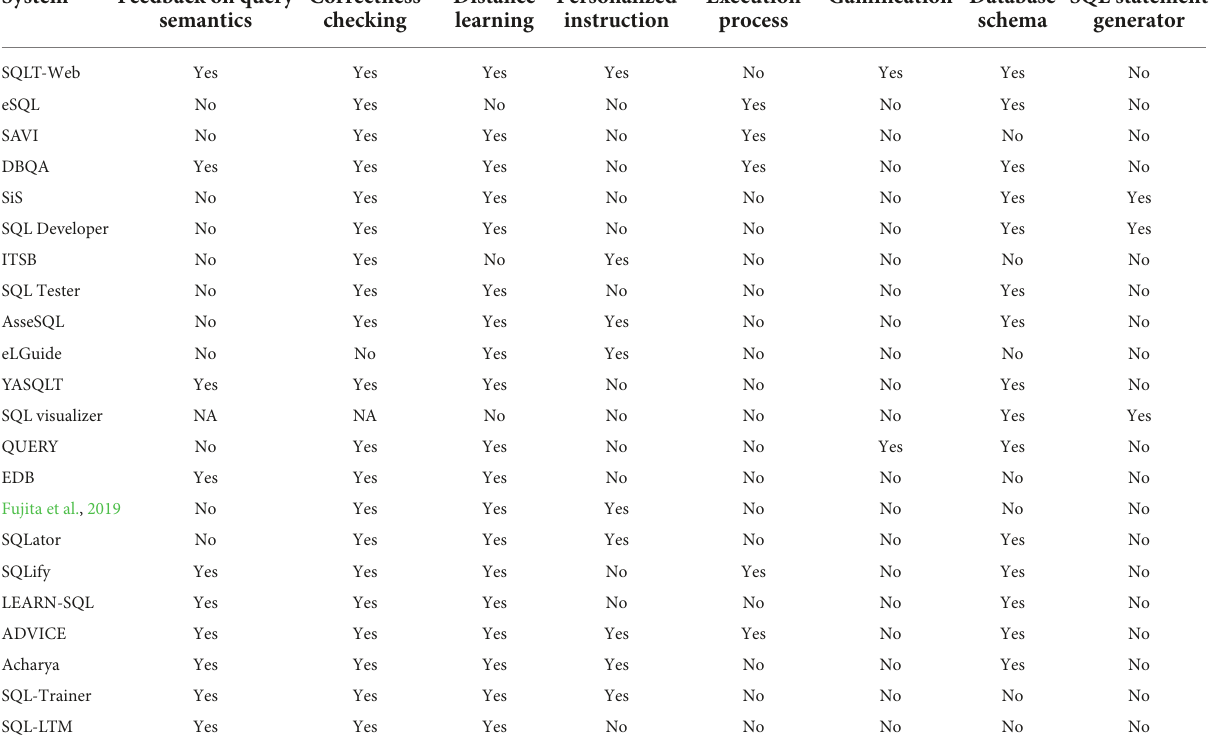
TABLE 1 An overview of tutoring systems.